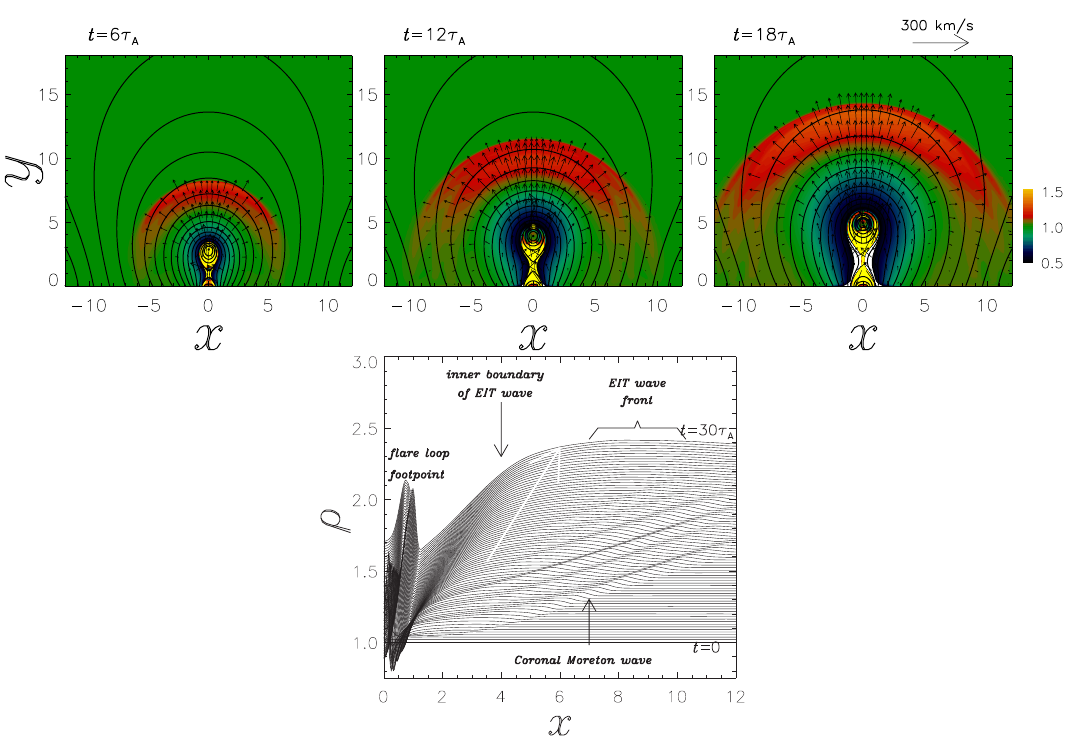
Figure 46: The hybrid model of Chen. Top : Evolution of density ( colors ), magnetic field ( lines ) and velocity ( arrows ). A rising flux rope drives a coronal shock wave ( red front ) whose flanks sweep over the chromosphere and cause the Moreton wave (from Chen et al. , 2005b). Bottom : Evolution of the density distribution at the coronal base. Two propagating density enhancements are seen: a fast one due to the shock ( coronal Moreton wave ), and a slower one due to field line stretching ( EIT wave ). Image reproduced with permission from Chen et al. (2005b), copyright by